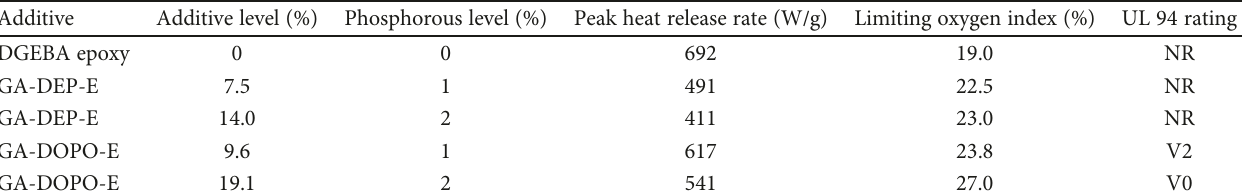
Table 4: Flammability characteristics of blends of phosphorous esters of gallic acid anilide with DGEBA epoxy resin. Additive Additive level (%)